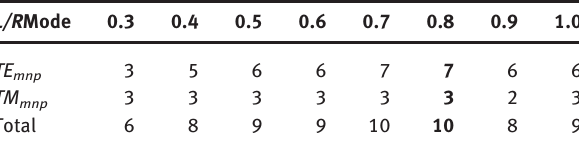
Table 1: The resonant modes of iso-volume cylindrical cavity at different dimensions.